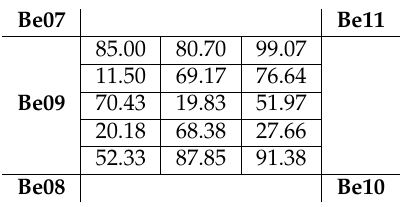
Table 5. Local accuracy in each sector of our experimental area with the most relevant transmission power level for SVM (with a quadratic polynomial kernel function). The centre shows the accuracy (in %) of each sector. Corners and middle-left hand are the position of BLE4.0 beacons with BeXY name. The most relevant transmission power level was